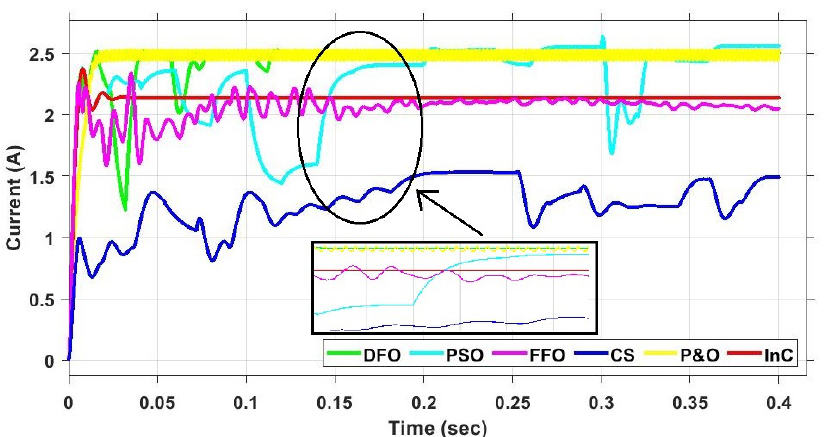
Figure 35. UI current comparison between all algorithms for MLPE Distributed PV